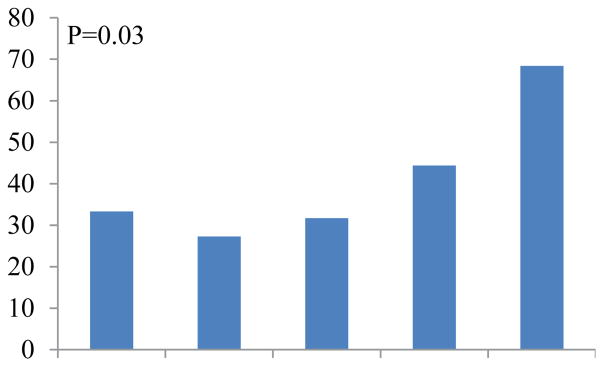
Proportion of patients with deficit in ADL.